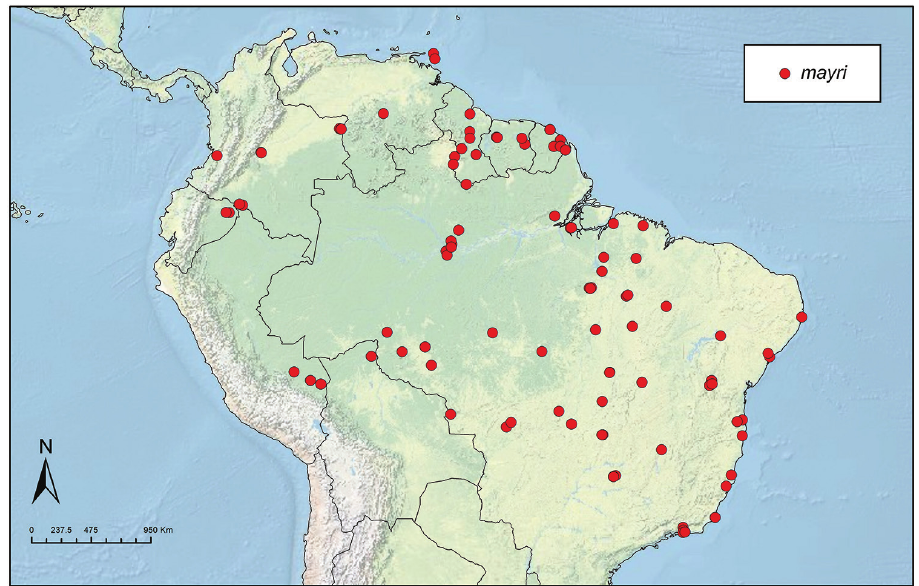
Figure 41. Distribution map of S.